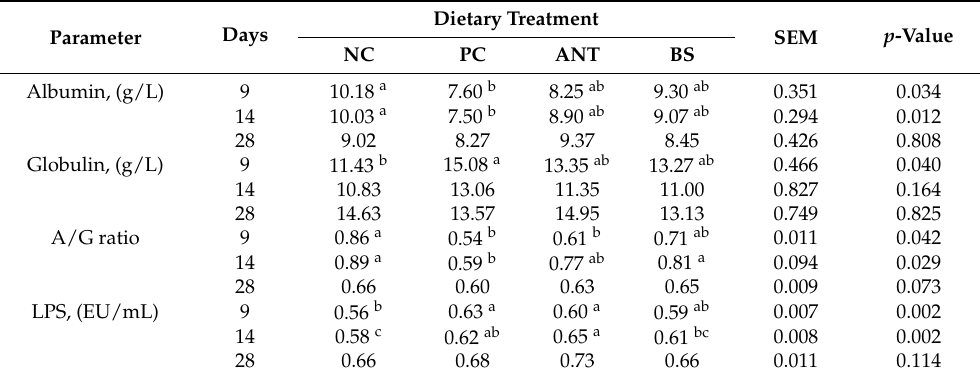
Table 2. Effect of B. subtilis on serum albumin, globulin, A/G ratio and LPS content of ducks challenged with E. coli